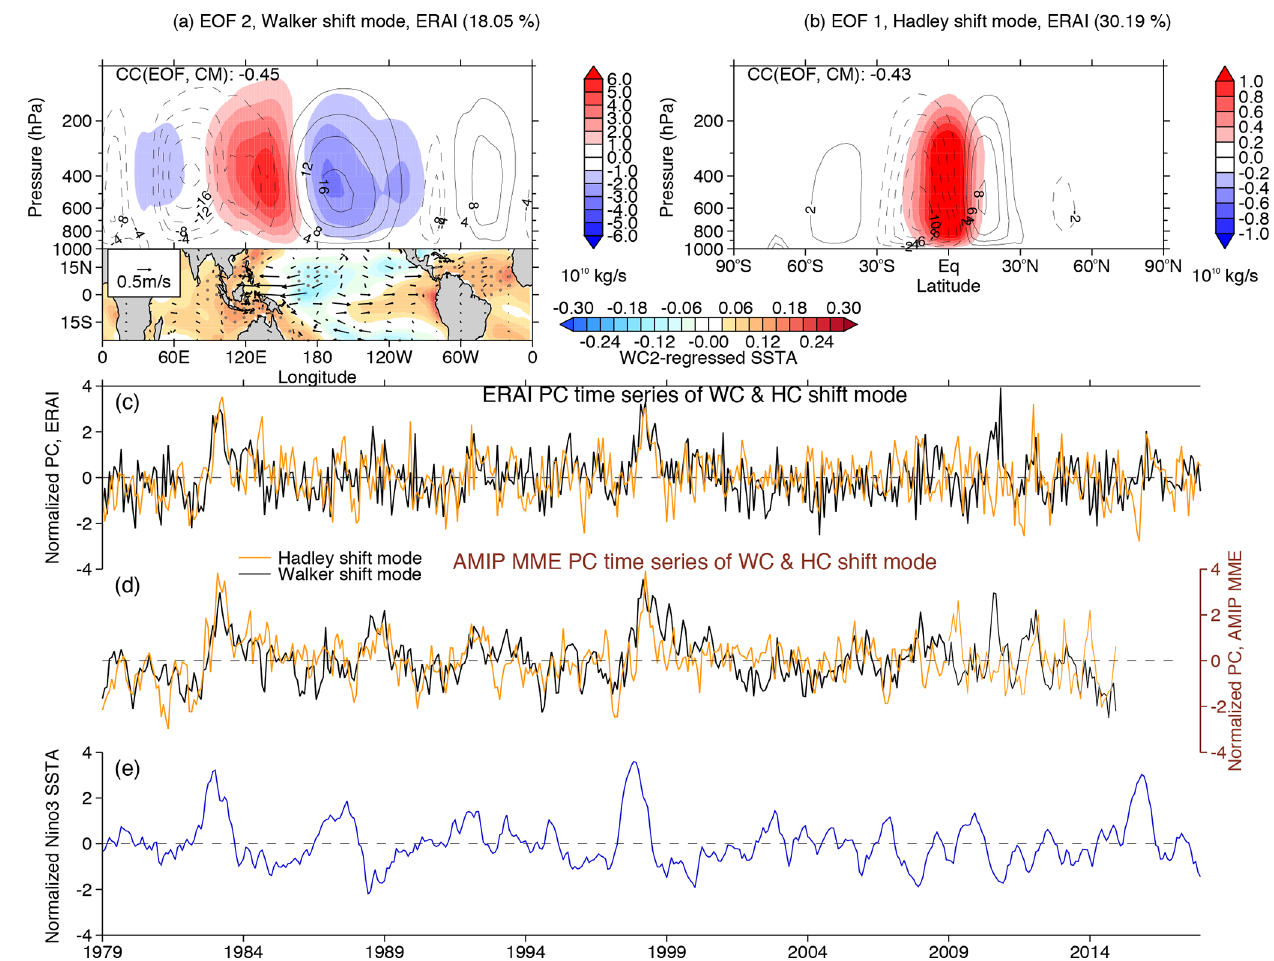
Figure 1. Phase-synchronized spatial shifts of the Walker and Hadley circulations. (a, b) The dominant patterns of the shift modes (i.e., EOF2 for Walker and EOF1 for Hadley; denoted by shading) for (a) Walker circulation (WC) and (b) Hadley circulation (HC) variability. The WC and HC are identified as (a) tropical (5 ◦ S–5 ◦ N) averaged mass stream function (MSF) anomalies and (b) zonally averaged MSF anomalies, obtained from the monthly ERA interim (ERAI) data during the period 1979–2017. The contours show the climatological mean (CM) of the MSF for the circulations. The pattern correlation coefficients (CCs) between EOF and CM are also displayed in (a, b) . The SST and 850hPa wind anomaly patterns regressed against the WC2 principal component (PC) are displayed as a bottom inset in (a) . (c, d) The normalized PC time series of the shift modes (i.e., WC2&HC1), derived from (c) ERAI and (d) the multi-model ensemble (MME) average for 40 AMIP models (1979–2008 for 19 AMIP5 and 1979–2014 for 21 AMIP6 models). (e) The normalized Niño3 SST anomaly (ERSSTv5) time